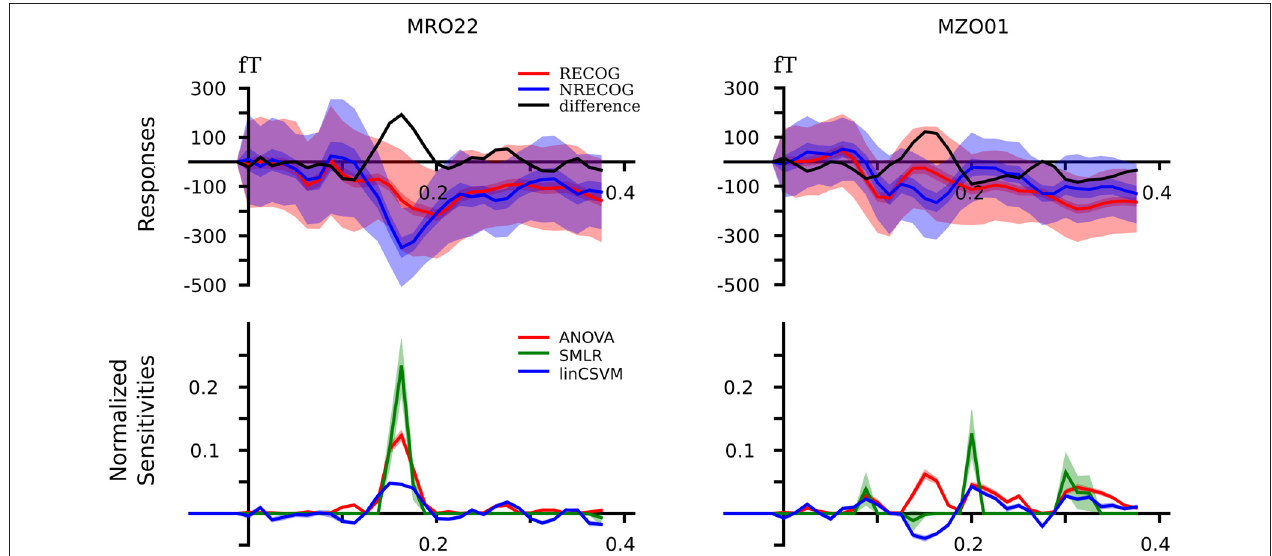
FIGURE 3 | Event-related magnetic fi elds (EMF) and classifi er sensitivities. The upper part shows EMFs for two exemplary MEG channels. On the left sensor MRO22 (right occipital), and on the right sensor MZO01 (central